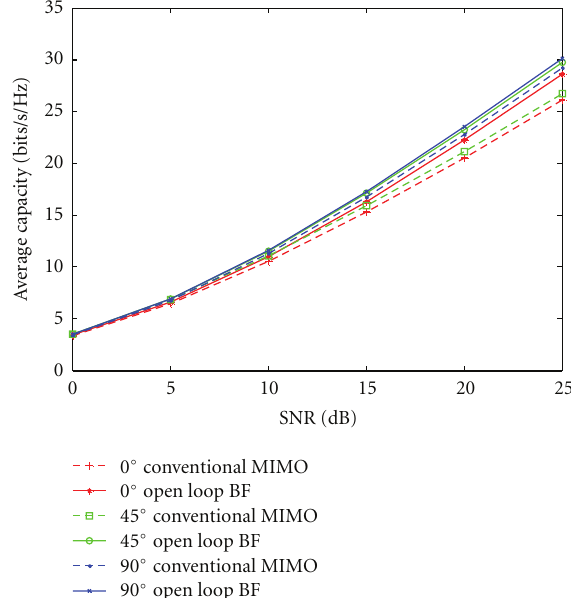
Figure 12: Average capacity (bits/s/Hz) versus SNR (dB) for various array directions at location